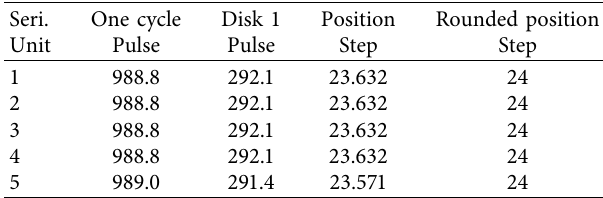
Figure 9: Position result of the pulse-counting method. Table 2: Experimental data of the optimized pulse-counting